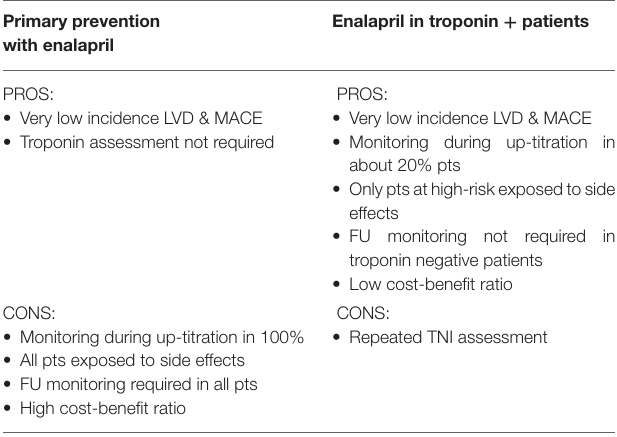
TABLE 5 | Pros and Cons of primary prevention vs. secondary prevention with enalapril ( 83).